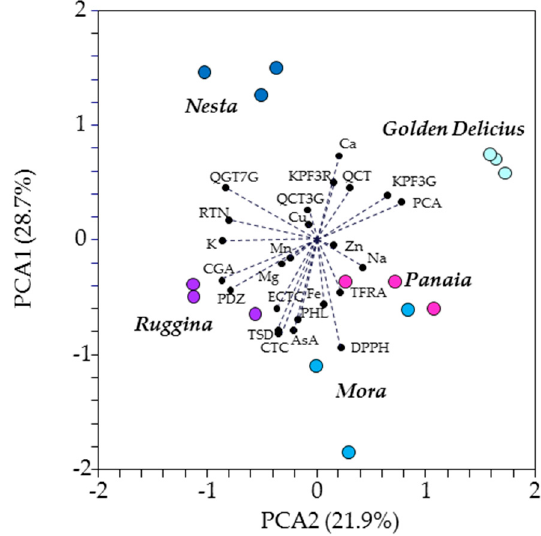
Figure 4. Principal component analysis of polyphenols profile (( − )-epicatechin (ECTC), chlorogenic acid (CGA), quercetin 3- O -glucoside (QCT3G), quercetin (QCT), phloridzin (PDZ), (+)-catechin (CTC), rutin (RTN), tiliroside (TSD), kaempferol 3- O -glucoside (KPF3G), kaempferol 7- O -glucoside (KPF7G), quercetagetin 7- O -glucoside (QGT7G), phloretin (PHL), p -coumaric acid (PCA), trans -ferulic Acid (TFRA), kaempferol 3- O -rutinoside (KPF3R), antioxidant capacity (DPPH) and mineral element composition (Zn, Mn, Cu, Na, Fe, Mg, Ca and K) of four ancient apple cultivars from Tuscany (‘Mora’, ‘Nesta’, ‘Panaia’ and ‘Ruggina’) and the commercial variety ‘Golden Delicious’.